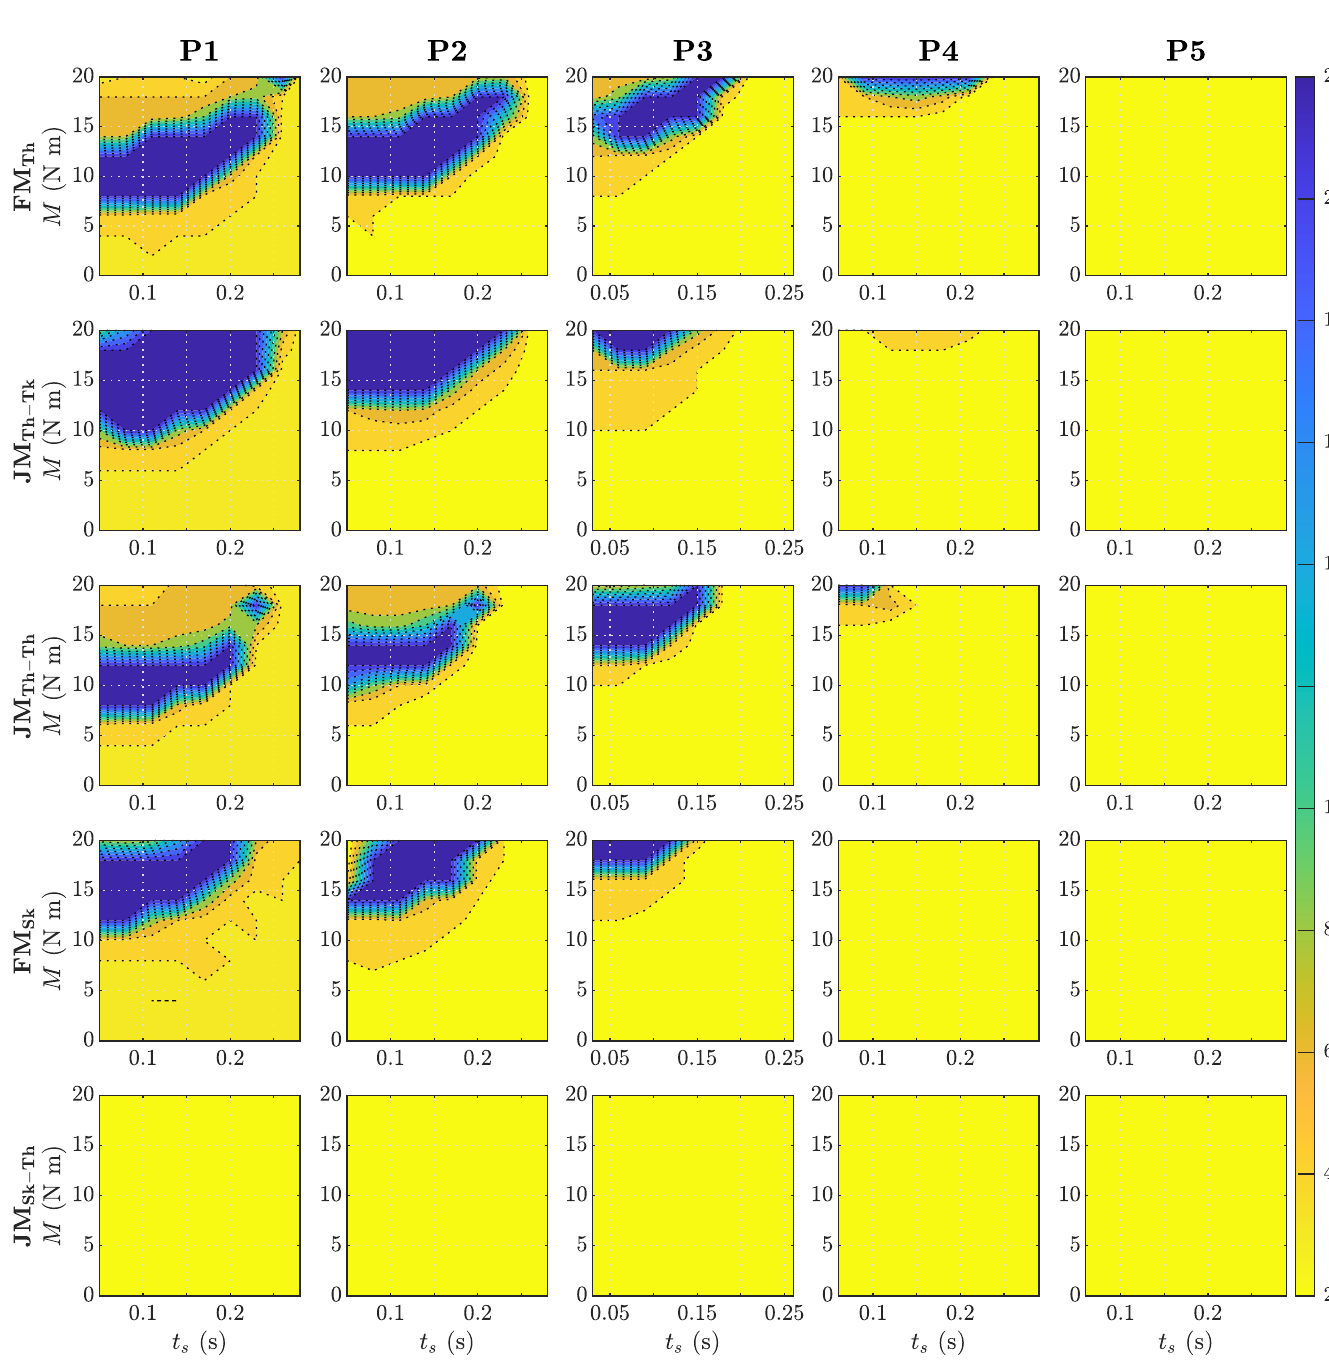
PLOS ONE | https://doi.org/10.1371/journal.pone.0280158 February 21, 2023 11 /